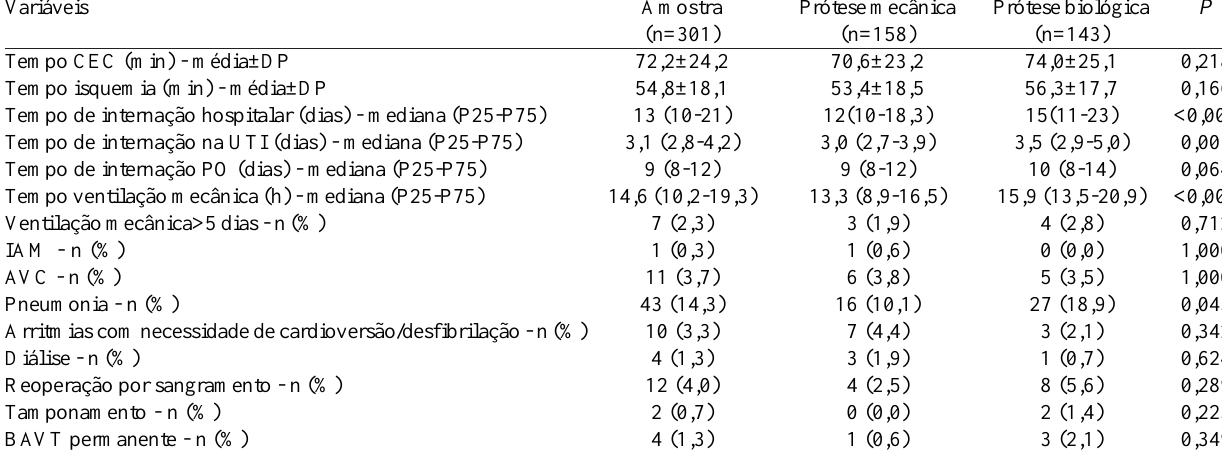
Tabela 2. Desfechos hospitalares